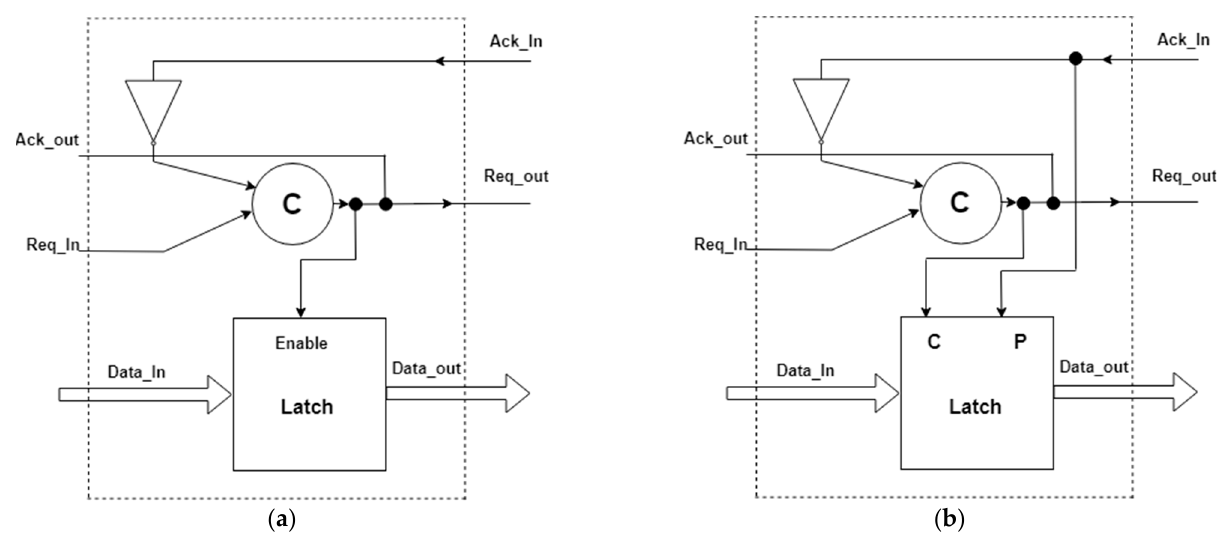
Figure 6. The asynchronous pipeline stage implemented using ( a ) four-phase and ( b ) two-phase techniques.